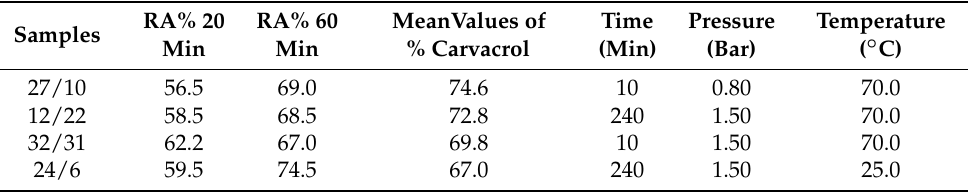
Table 7. Antioxidant activity (mean values of RA% values) in correlation with the mean % values of carvacrol content and with the distillation process factors